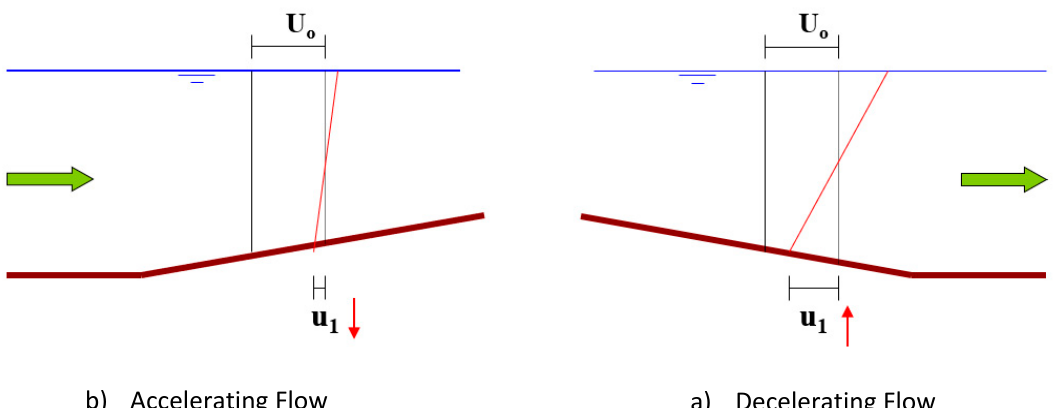
Figure 2. Variation of the moment velocity scale, u 1 , for accelerating and decelerating flow.